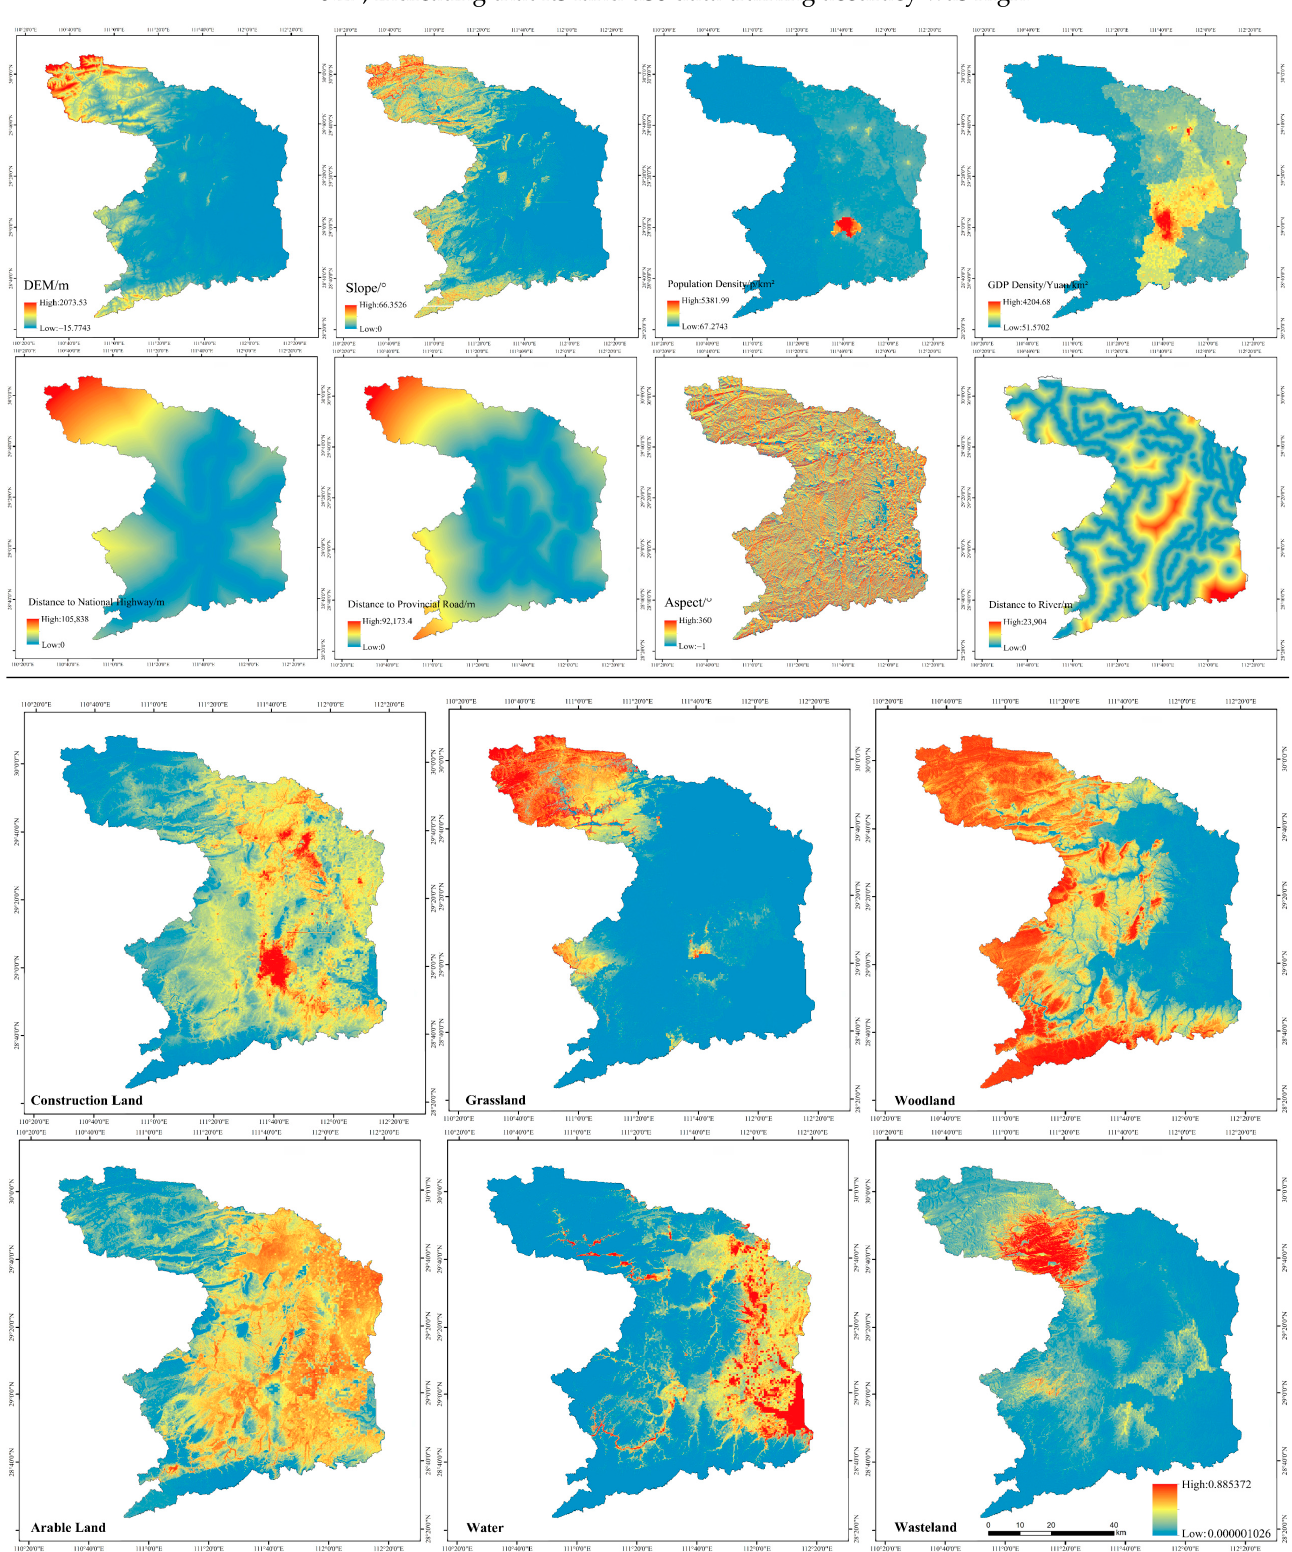
Figure 4. Driving factors for calculating the different land-use probabilities of occurrence in 2018.